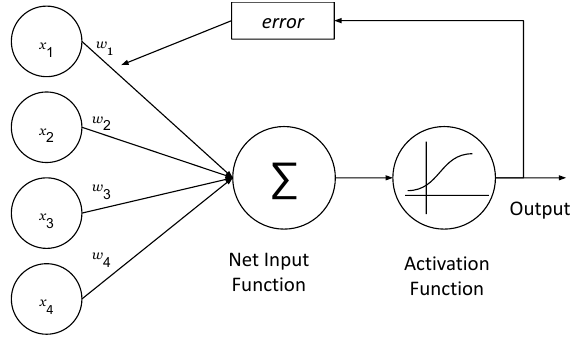
Figure 2. Neuron with Error Back